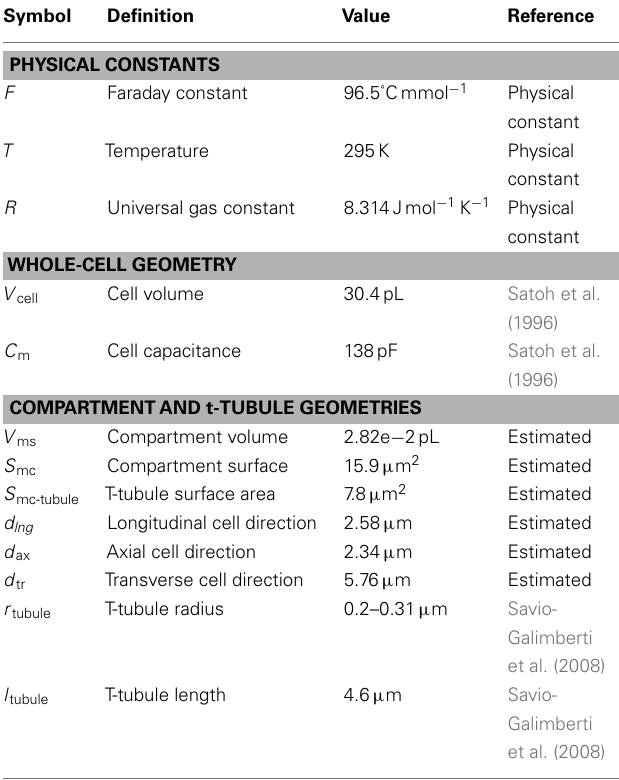
TableA1 | Physical constants and cell geometry